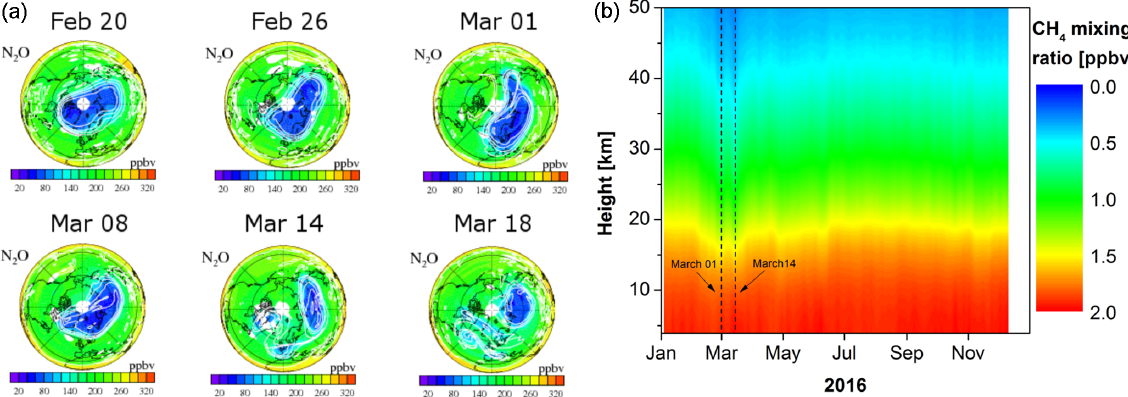
Figure 8. In (a) N 2 O MLS data from the Aura satellite are shown as a tracer for the position of the polar vortex for several days in February and March 2016. Data and plots courtesy of the NASA science team (https://mls.jpl.nasa.gov/, last access: 4 March 2019). (b) shows CH 4 mixing ratios from NDACC FTIR station Jungfraujoch in Switzerland, downloaded from the NDACC archive (http://www.ndaccdemo.org/ stations/jungfraujoch-switzerland/, last access: 4 March 2019). For dates with no measurements the data have been interpolated using a weighted average. Dotted lines depict 1 and 14 March 2016. For these dates, the XCH 4 data significantly differ from the remaining data